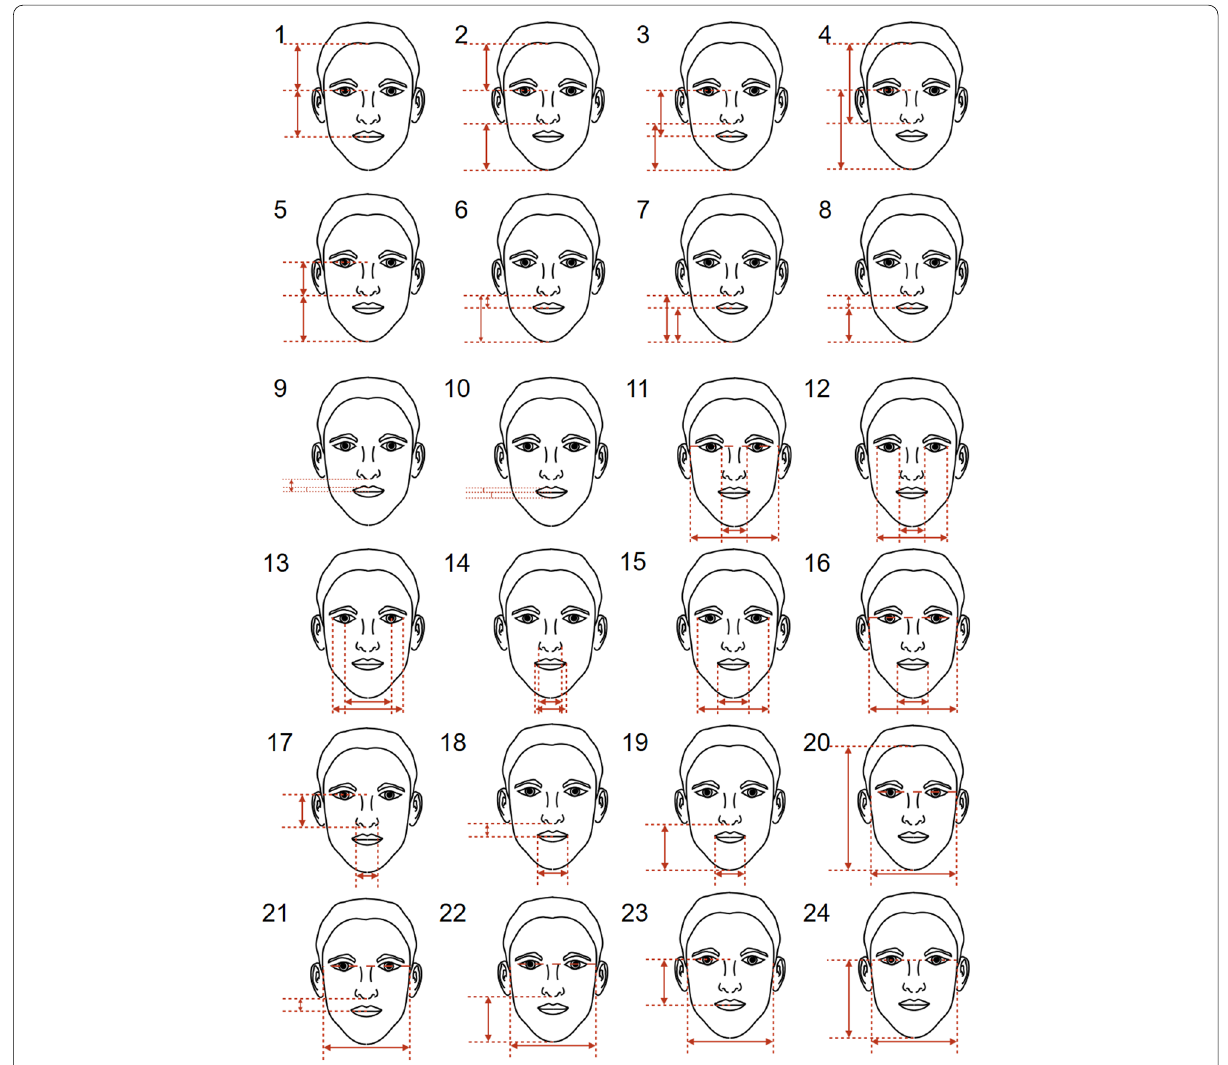
Fig. 5 ‘Ideal’ ratio parameters measured in this